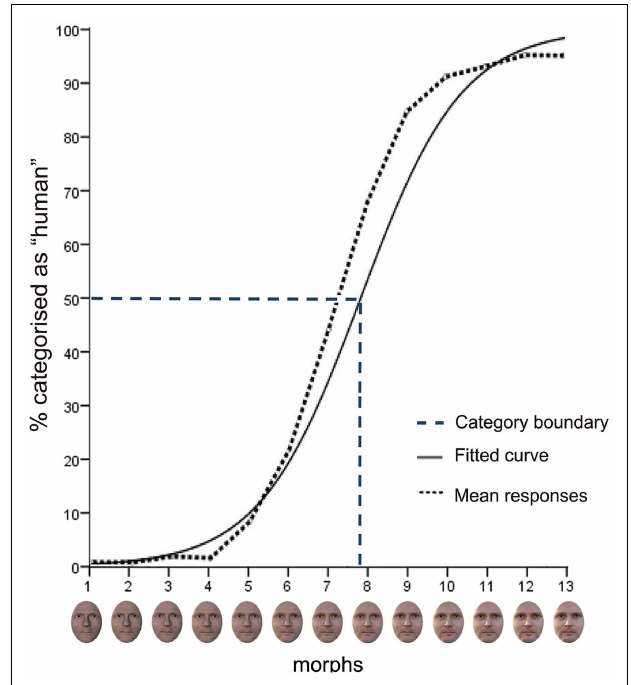
FIGURE 3 | Mean responses in the categorization task. The mean aggregated response (dotted line), shown in terms of the percentage of “human” responses, and the mean logistic curve (continuous line) across all continua and participants are displayed.The mean category boundary (dashed line) indicates the morph position along the continua at which there is maximum uncertainty of 50% in categorization judgments.The bottom panel of the figure shows an example of a morph